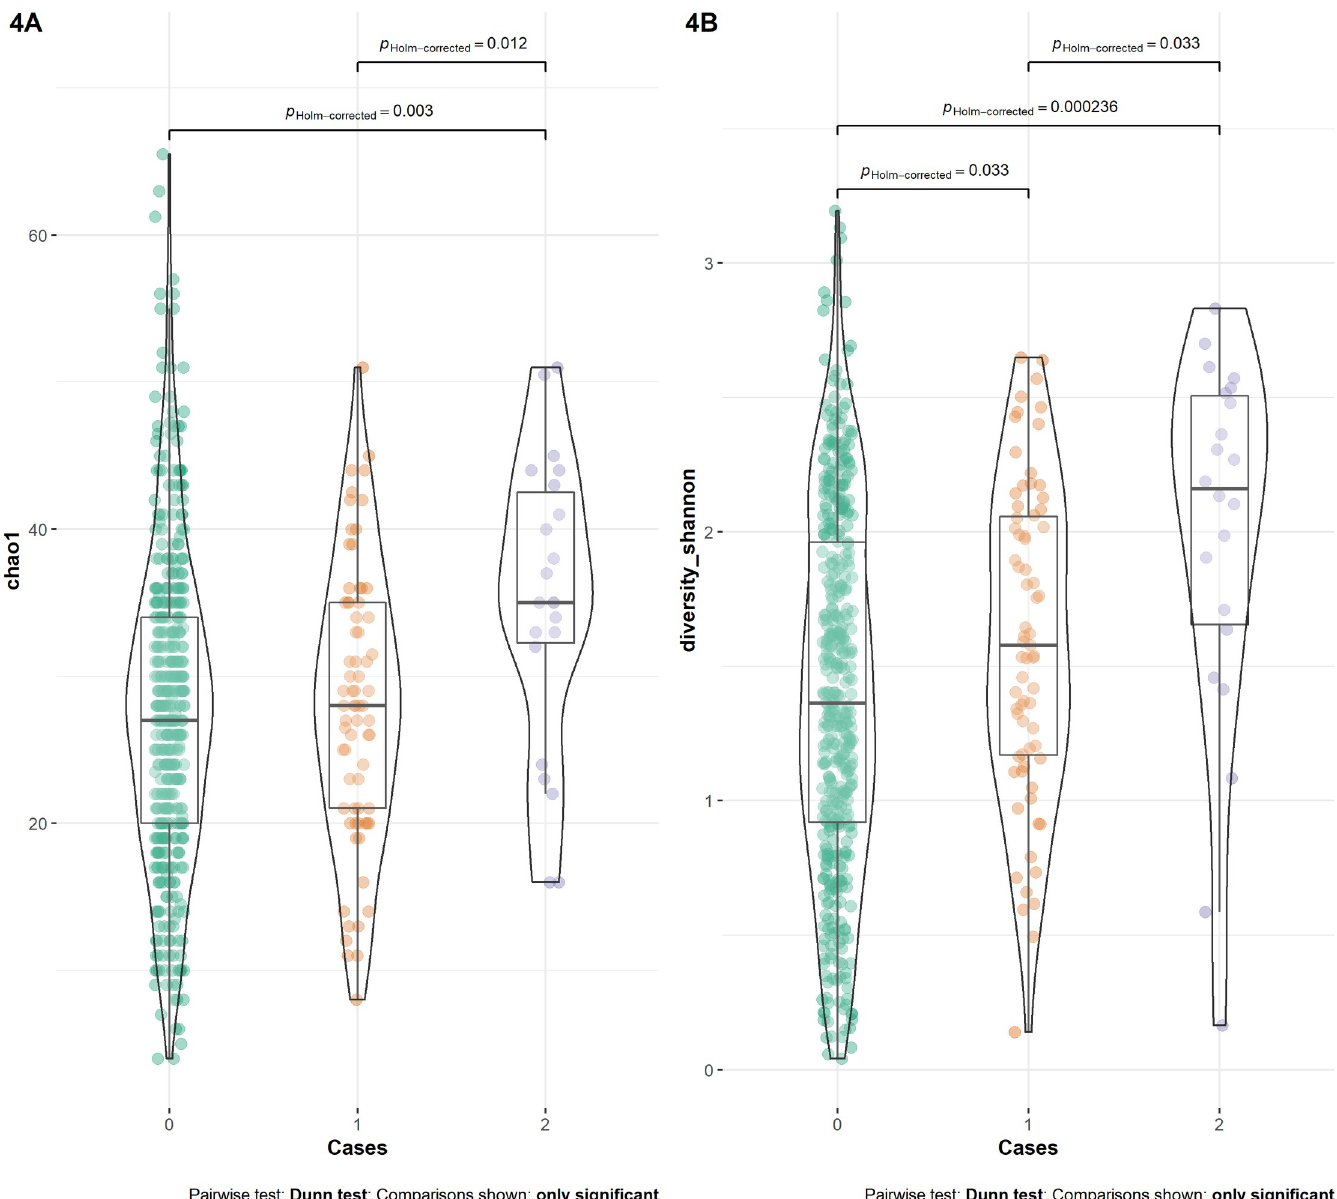
Fig 4. Boxplot of α -diversity. Fig 4A presents the violin-plot of Chao1 diversity in controls, lesional and non-lesional cases. Fig 4B presents the violin-plot of Shannon diversity in controls, lesional and non-lesional cases. P-values are adjusted pair-wise comparisons. Overall Kruskal-Wallis test is described in the text.